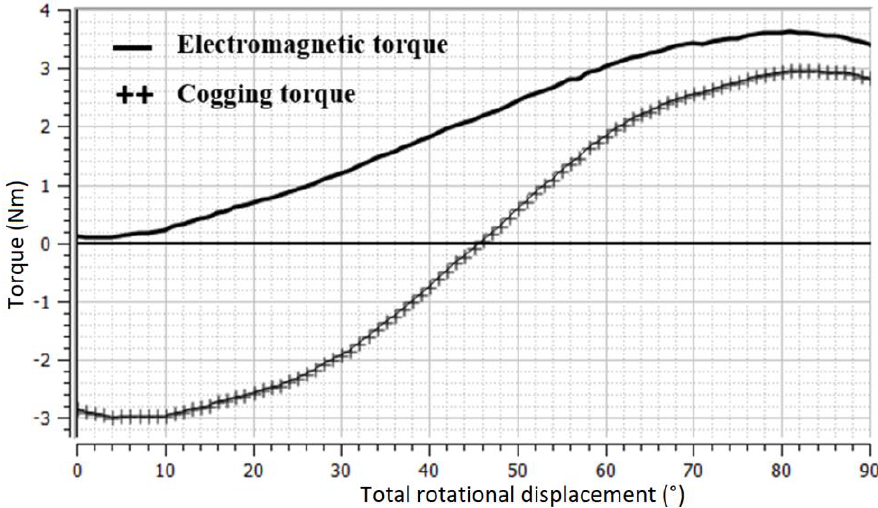
Figure 5. Electromagnetic and cogging torque obtained from the 3D analysis.